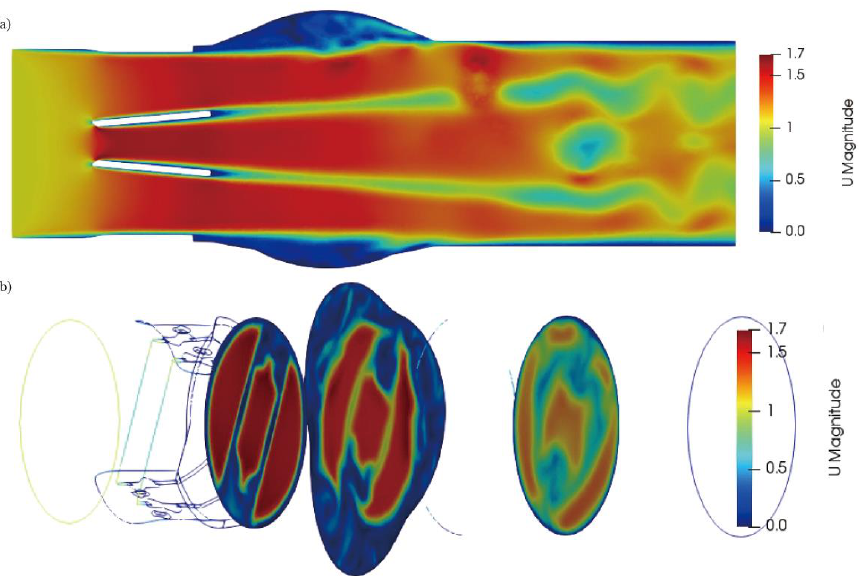
Figure 11. Peak ststolephase velocity contours ( a ) at the mid-plane ( b ) at the three planes with different distances from the valve (Newtonian model).